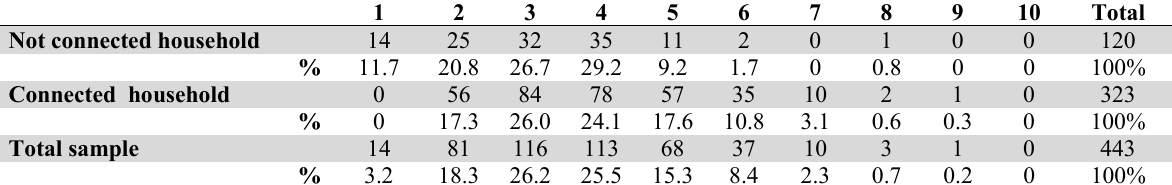
Arsenic awareness